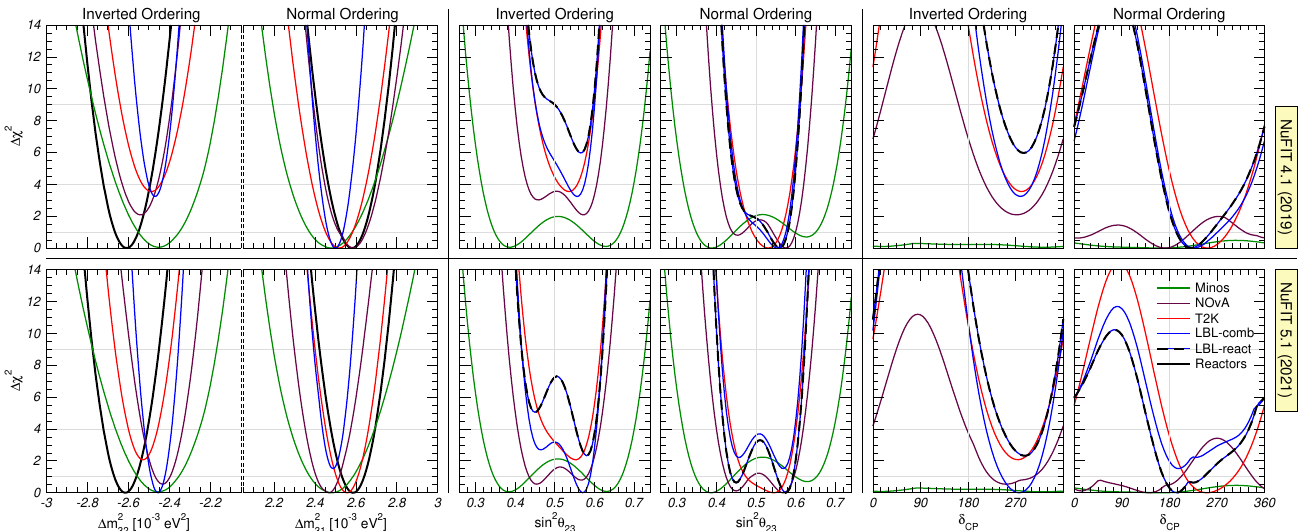
Figure 5. ∆ χ 2 -profiles as a function of ∆ m 2 ( left ), sin 2 θ 23 ( center ) and δ CP ( right ) for different LBL and reactor data sets 3 (cid:96) and their combination obtained in NuFIT 4.1 and NuFIT 5.1. For all curves we have fixed sin 2 θ 13 = 0.0224 as well as the solar parameters and minimised with respect to the other undisplayed parameters. ∆ χ 2 is shown with respect to the best-fit mass ordering for each curve. Figure adapted from